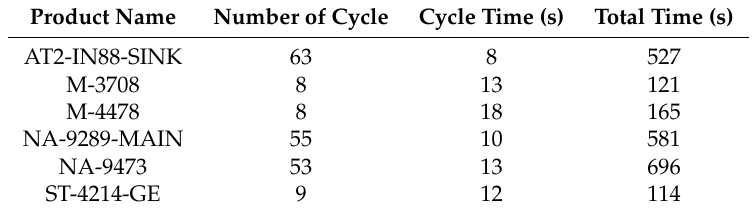
Table 3. Dataset collected from Surface Mounted Device (SMD) assembly machine (Set-A).